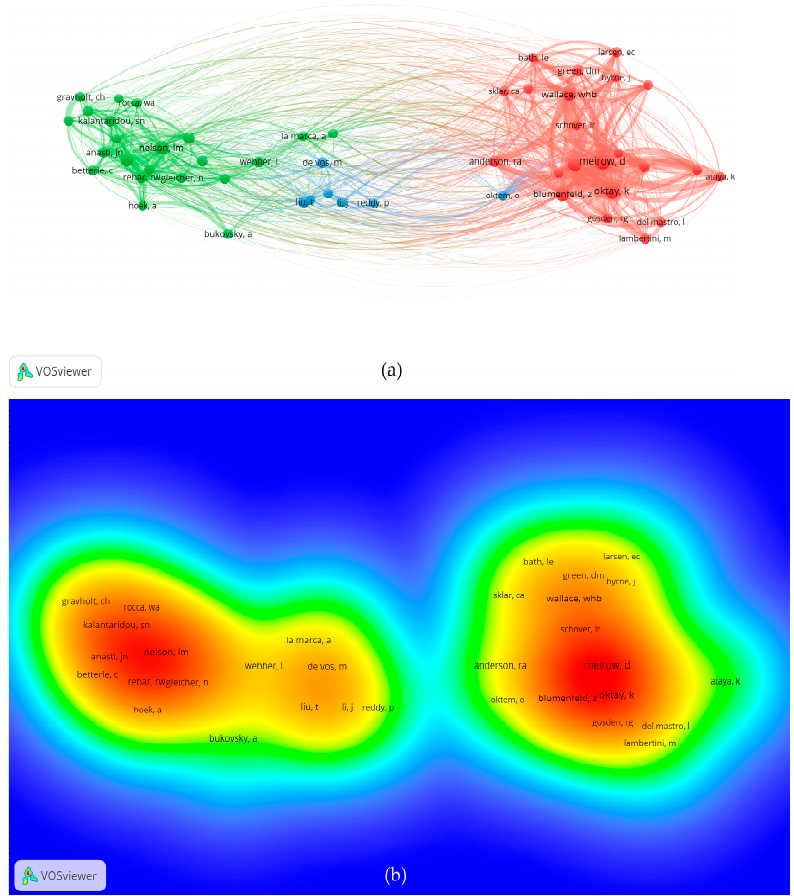
Figure 6. Author co-citation visualization map on therapy for POI. ( a ) The network map of co-citation (cited authors). The threshold for the minimum number of citations of an author was set to 50. A total of 51 authors who met the threshold were identified. ( b ) The density map of co-citations (cited authors). The size of a node is proportional to the total number of citations of the author, and the thickness of the connecting line indicates the strength of the co-citation link.